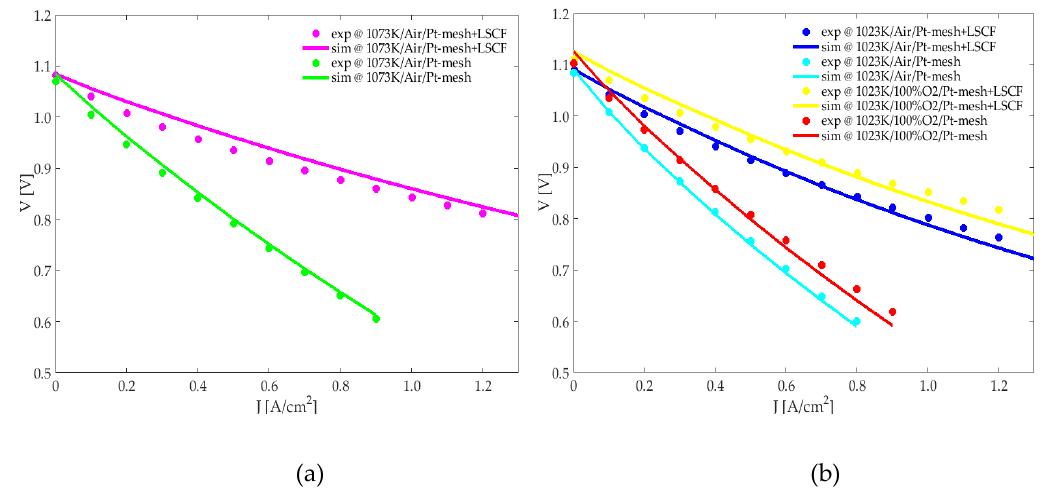
Figure 3. Experimental and simulated I–V curves at H 2 /H 2 O 97/3 and different temperatures: ( a ) 1073 K and ( b ) 1023 K.